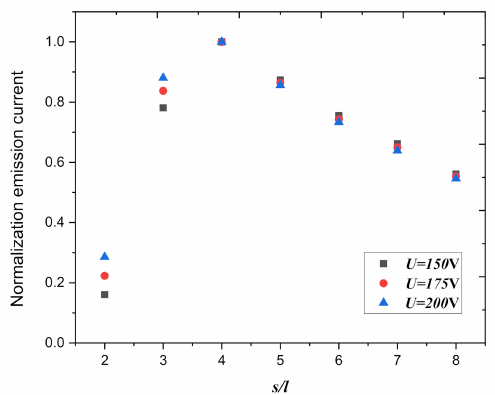
Figure 8. The normalization field emission current in 10 cm 2 as a function of the normalization spacing, for the anode voltage, is chosen to be 150 V, 175 V, and 200 V ( d = 2.75 µ m).